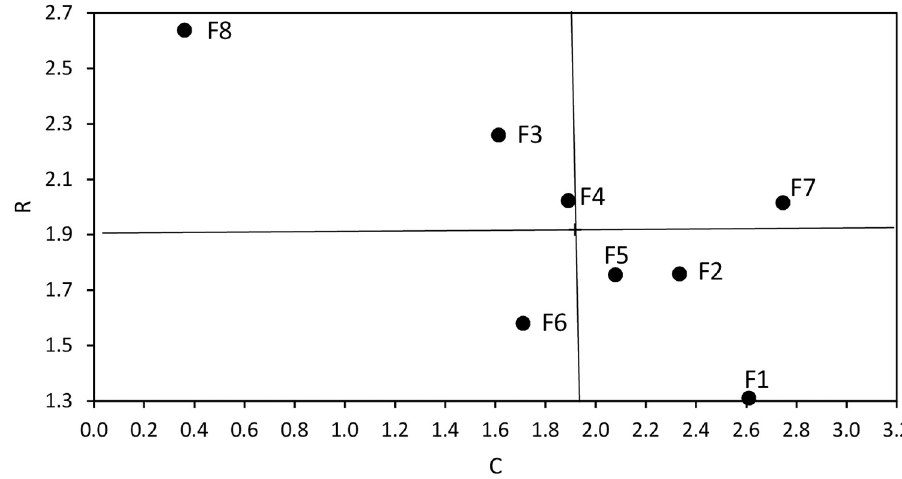
Fig 2. Diagram of influential